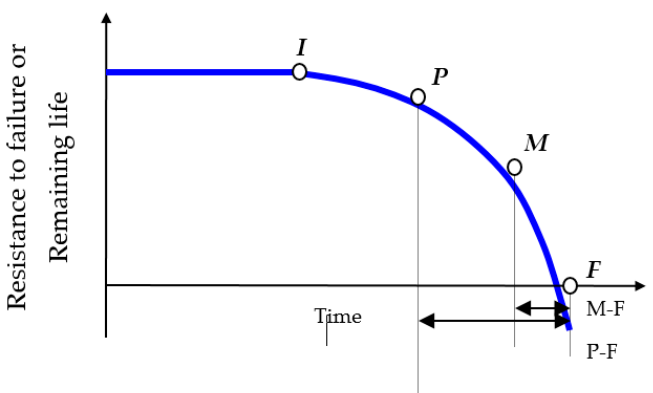
Figure 1. P-F curve (authors’ figure).